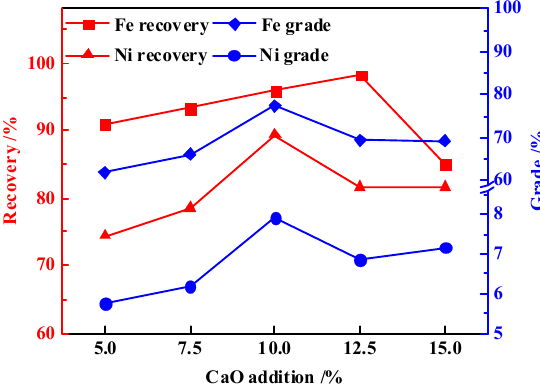
Figure 11. Effects of CaO addition on grades and recoveries of Ni and Fe.